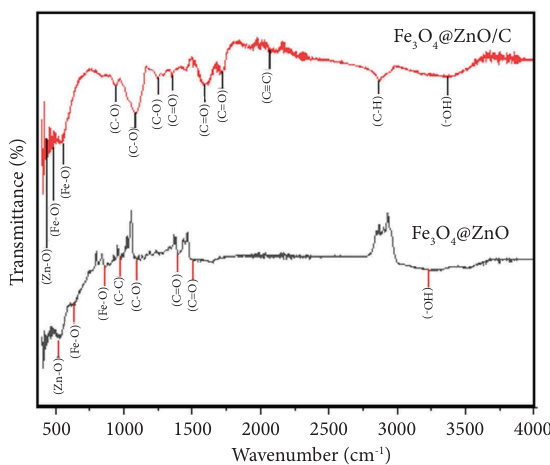
Figure 2: FTIR spectra of Fe